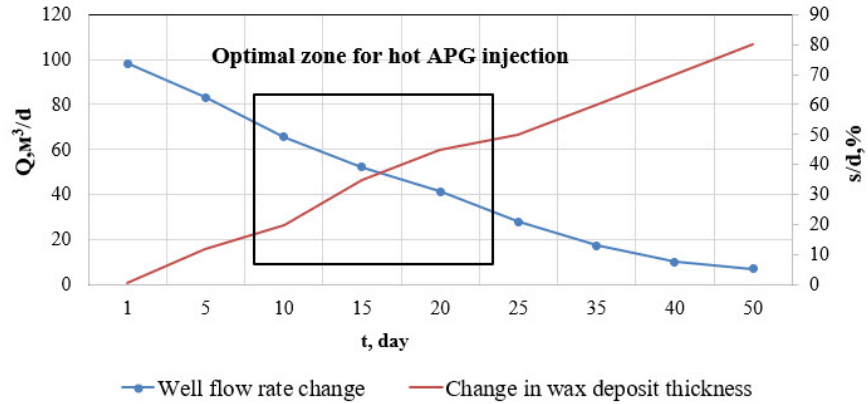
Figure 6. Determination of the optimal hot APG injection period.